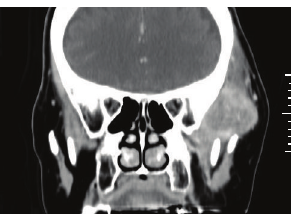
Figure 3: Preoperative contrast CT showing ill-demarcated low- density mass with enhancement of the adjacent temporal muscle.